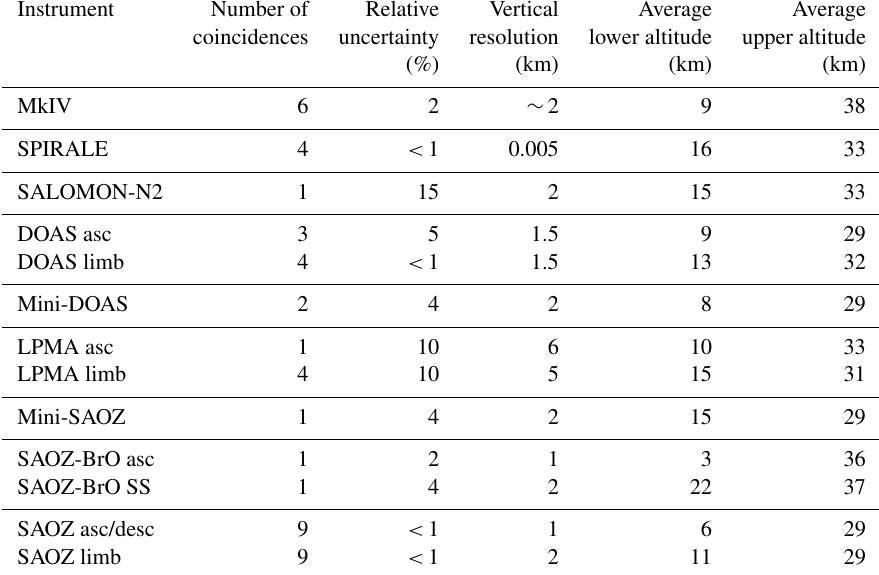
Table 2. Summary of validation data based on OSIRIS coincidences. The minimum relative uncertainty is reported on the native vertical grid. Vertical resolution is quoted or calculated for an altitude of 16km. The vertical resolution is provided by Butz (2006) for LPMA and DOAS, Weidner et al. (2005) for mini-DOAS, available at http://mark4sun.jpl.nasa.gov/m4data.html for MkIV, and calculated for limb occultation for the SAOZ-type instruments, including SALOMON-N2 (Jégou et al., 2013), assuming vertical resolution equal to the vertical extent of the solar disk at the tangent point. Uncertainties are for a 1km vertical grid, except for SPIRALE (0.005km) and mini-DOAS (2km). Instrument Number of Relative Vertical Average Average coincidences uncertainty resolution lower altitude upper altitude (%)